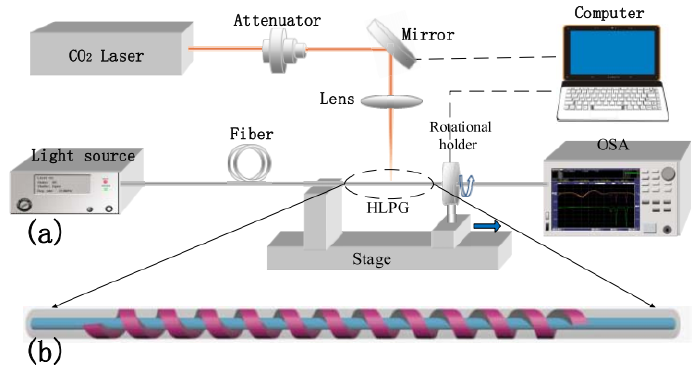
Figure 7. Setup for fabrication of the twisted HLPG by using focused CO 2 laser beam. ( a ) Setup and ( b ) schematic diagram of the index-modulation originated in HLPG. © [2021] IEEE. Reprinted, with permission, from Ref. [19]. permission, from Ref.